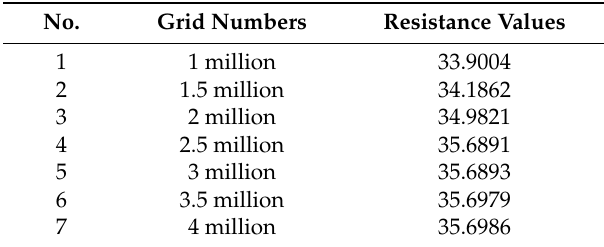
Table 1. Resistance values of the models with different grid